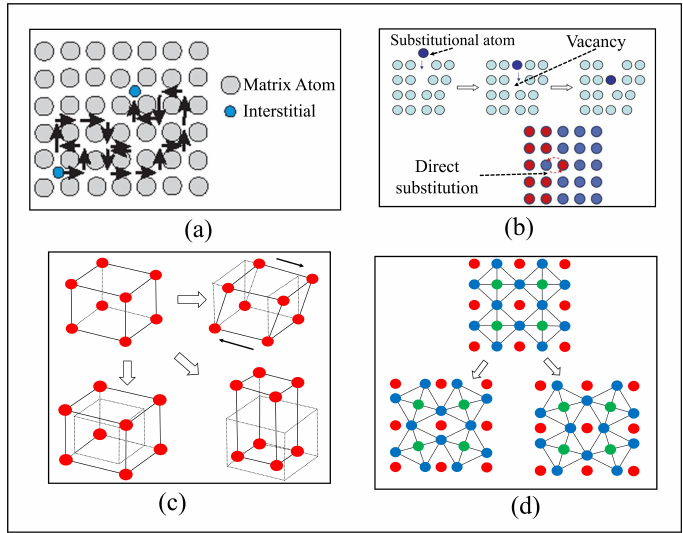
Figure 2. Two types of transformation: Diffusion transport ( a , b ) and diffusion-less transformation ( c , d ) in crystal structure are shown. The image ( a ) shows an interstitial diffusion where a different kind of atom takes an interstitial position inside the matrix of different kind of atom crystal lattice [5]. Substitutional diffusion inside the crystal structure occupying a vacancy by foreign atom is presented in ( b ) top [7] , where as a direct substitution of two different atoms within the lattice in ( b ) bottom [8]. The lattice-distortive strain transformation where a cubic lattice is distorted into another cubic with different forms as shear along a plane, or extenstion along certain axes or contraction in one axis and extension in other is shown in ( c ) [9]. The picture ( d ) shows a shuffle type displacements occurring via a clockwise (left) and counter-clockwise (right) rotation of one type of atom around other type of atom inside a lattice [9]. Adapted with permission from ( a ) [5], ( b ) [7,8], ( c ) [9], and ( d )